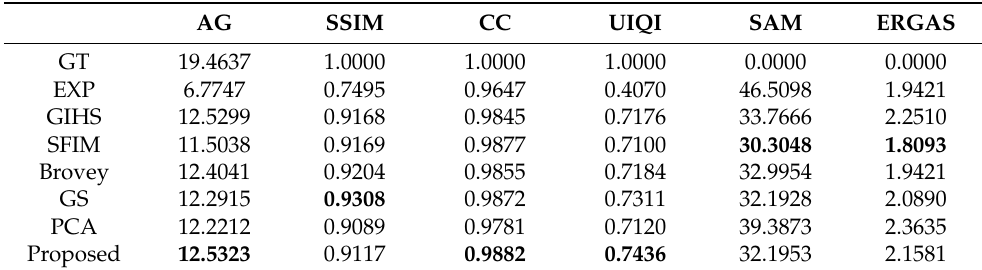
Figure 5. Fusion results for the WV-4 images using different methods. Table 3. Objective assessment indexes of the WV-4 image fusion